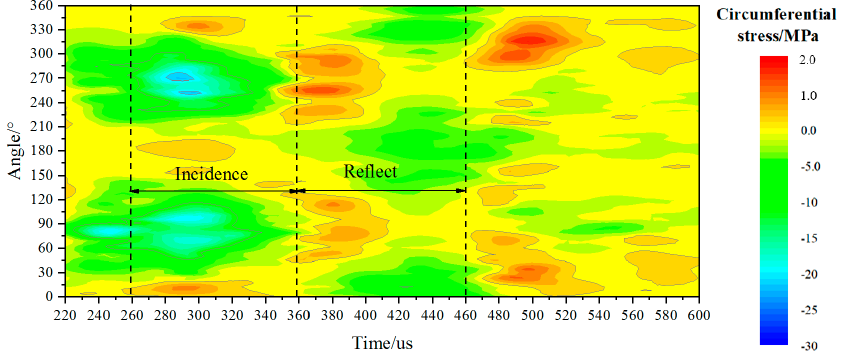
Figure 13. Temporal and spatial variation in hoop stress. Note: positive and negative values represent tensile stress and compressive stress, respectively.